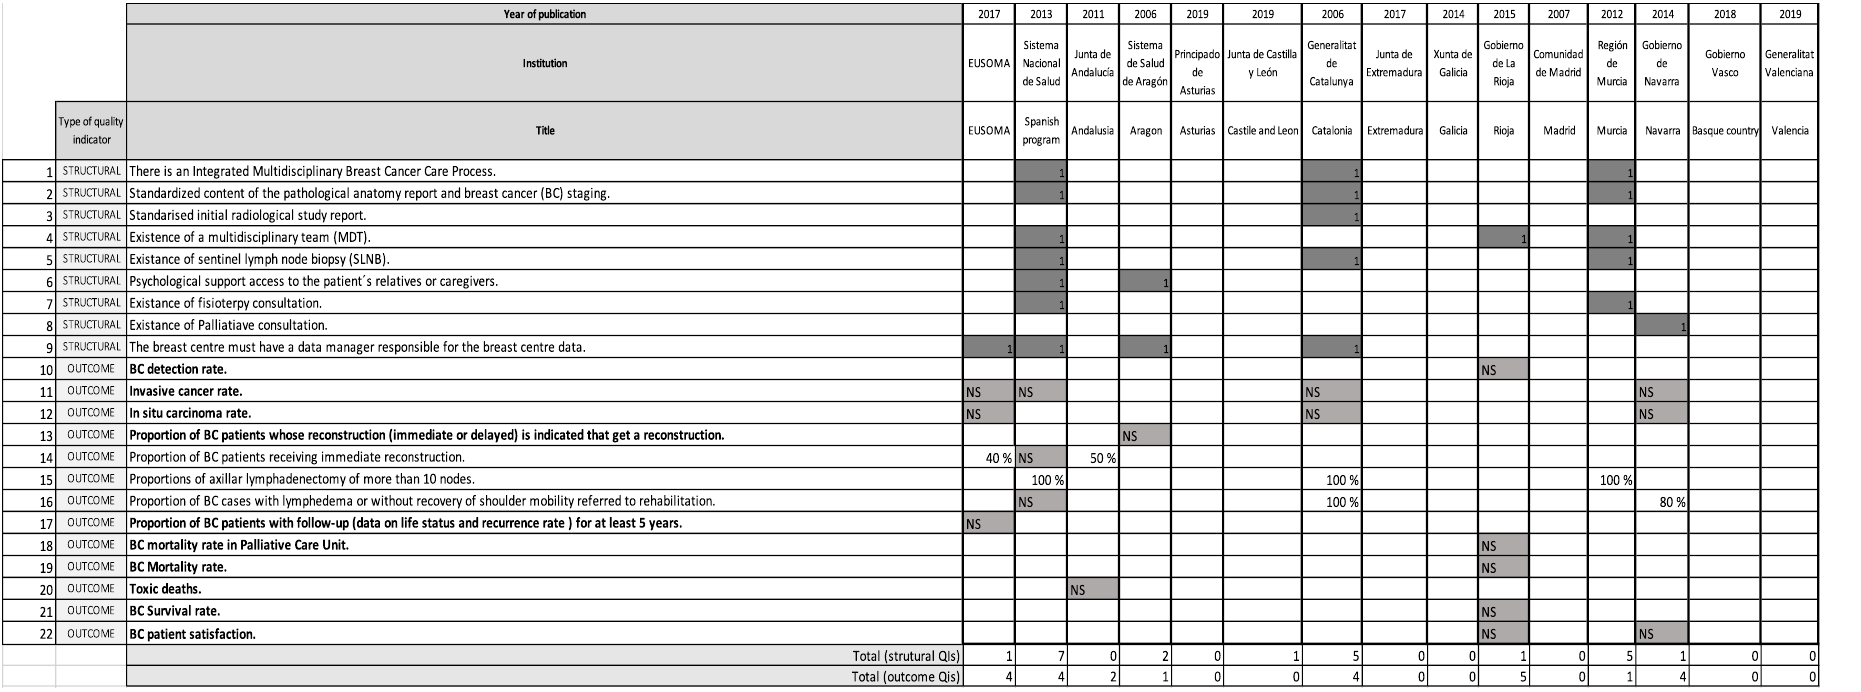
Figure 4. Quality indicators of structure and outcome in the Spanish breast cancer integrated health care processes and clinical pathways analysed .